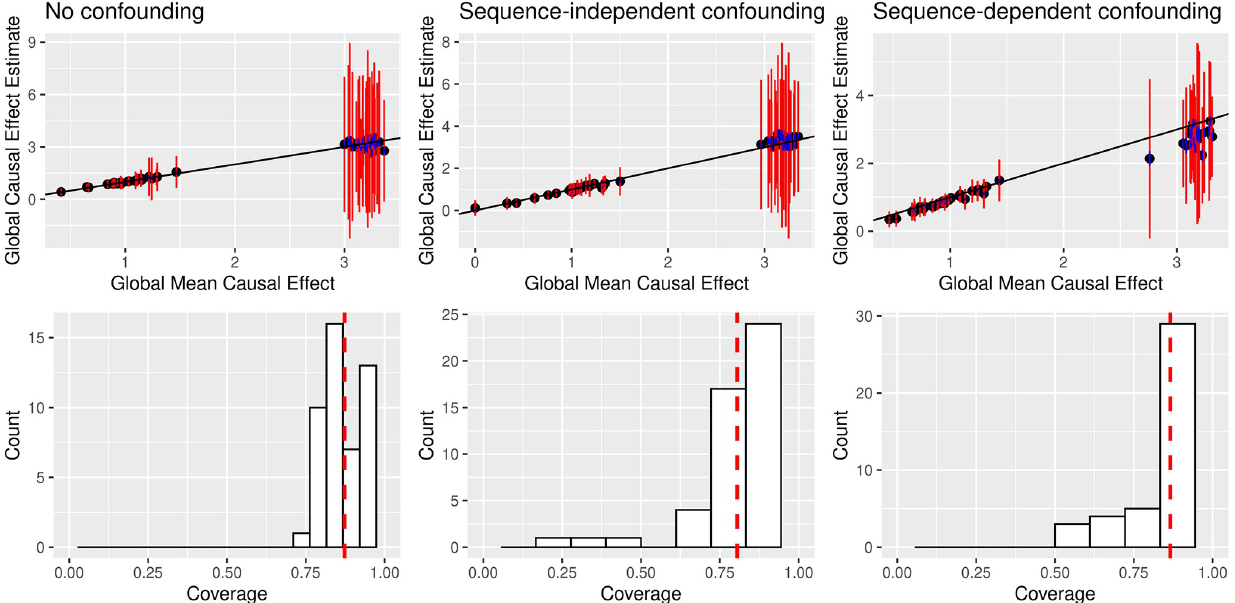
Fig 2. In simulations, DeepMR estimates causal effects between TFs even in the presence of unobserved confounding. Top row : true vs. estimated global causal effects (CEs) across 50 rounds for unconfounded, random confounded, and sequence-dependent confounded cases respectively. Blue bars denote ± 2 σ where σ denotes the standard error of the mean and orange bars denote ± 2 τ where τ denotes the between-region standard deviation. Bottom row : local CE coverage (how often the true CE is in the 95% confidence interval) across the three experiments (same order) with the red line denoting average coverage.